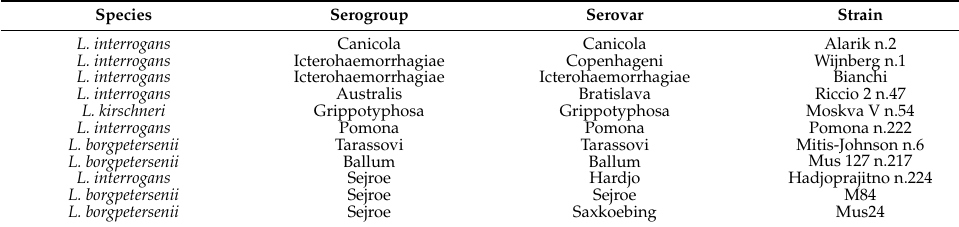
Table 1. Panel of eleven Leptospira spp. used as live antigens for the MAT assay.